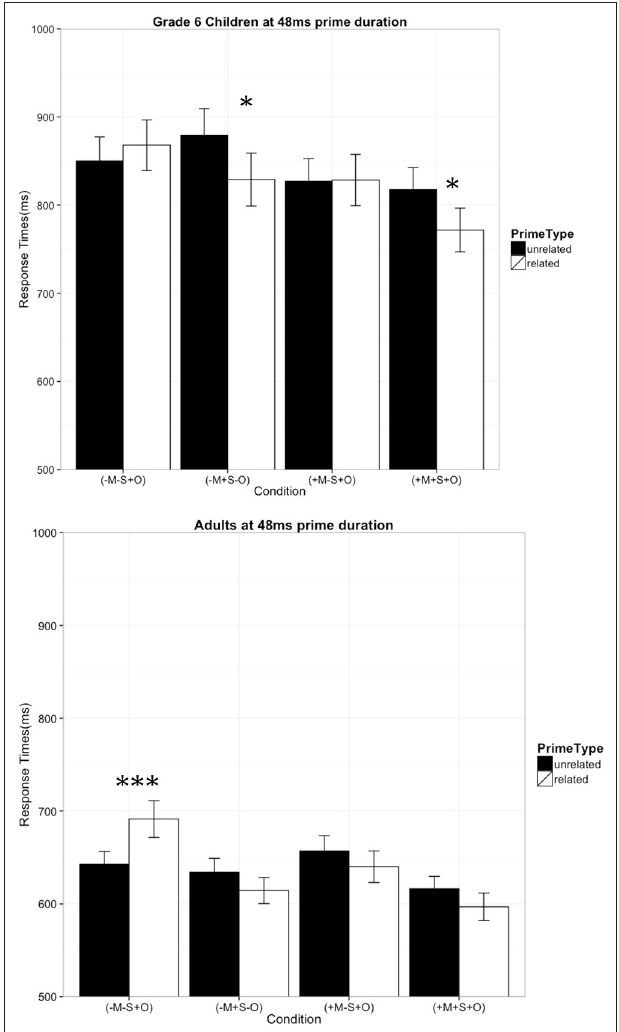
FIGURE 2 | Priming effects in reaction times in Experiment 2 (* p < 0.05, *** p <